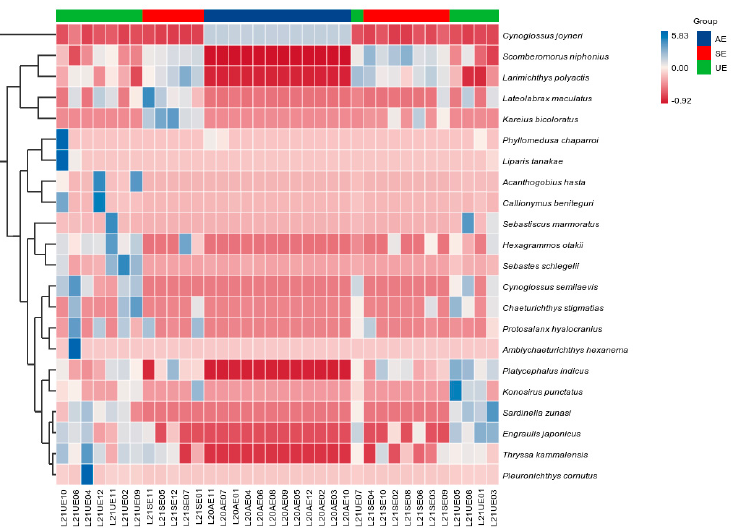
Figure 5. In the figure, samples are clustered as per distance metric (default clustering method) of the organism mixture information for UPGMA and are sorted based on the clustering results; nevertheless, they are arranged according to the default order of samples/groups. Species are clustered by default, i.e., UPGMA network topologies based on the Pearson coefficient of correlation matrix of their constituent information (default clustering algorithm), and ranked based on the clustering results. However, species are ranked based on their average abundant supply in the sample/group. (Subgroup AE: Autumn of 2020. Subgroup SE: in the spring of 2021. Subgroup UE: the summer of 2021).